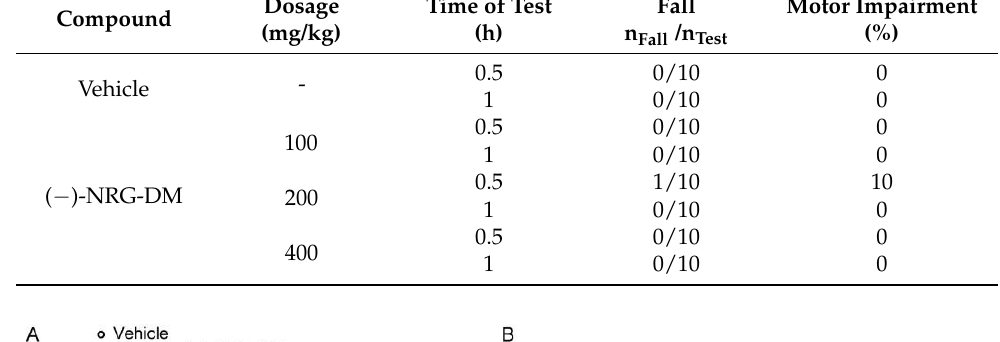
Table 1. Effects of ( − )-NRG-DM on motor impairment in the rotarod test in ICR mice. Compound